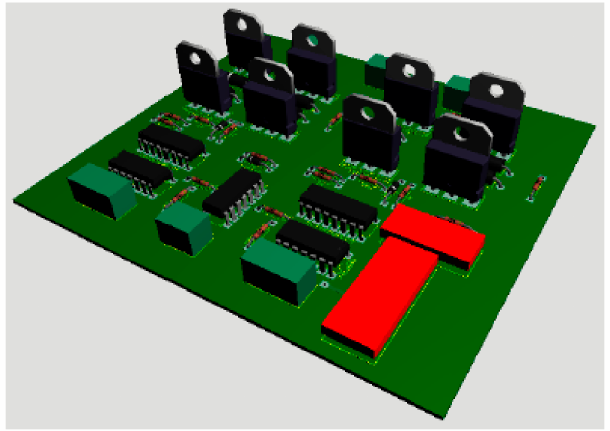
Figure 12. 3D Design of H-Bridge.